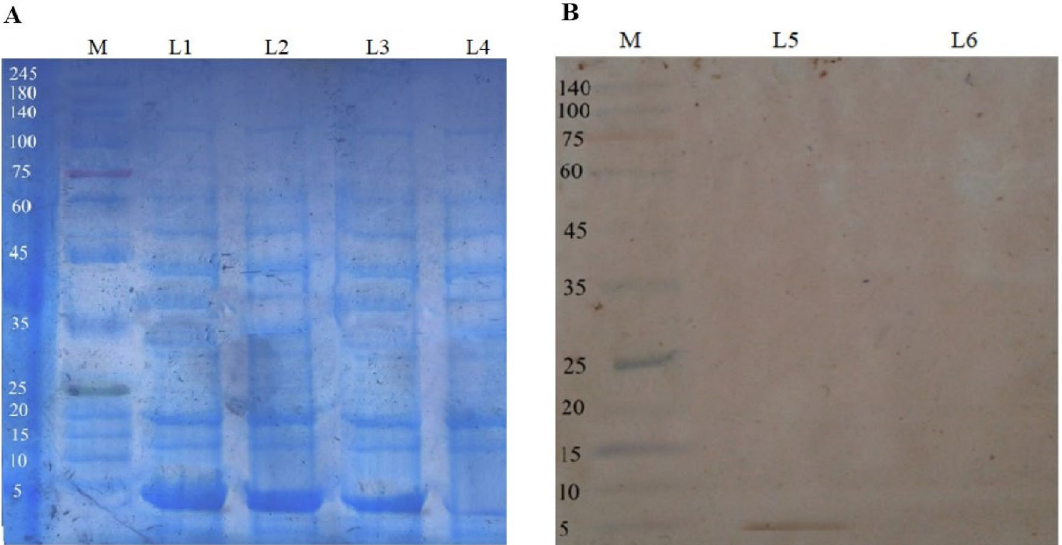
Figure 5. ( A ) Profile of the expressed buforin I in E. coli BL21 (DE3) cells at different sampling times; ( B ) Western blot analysis of the buforin I. M) protein ladder, L1) 6 h, L2) 4 h, L3) 2 h, L4) E. coli BL21 lacking recombinant plasmid (negative control), L5) E. coli BL21 cell harboring the plasmid pET22b ( +)-BUF, L6) E. coli BL21 harboring an intact pET22b (+) vector as the negative